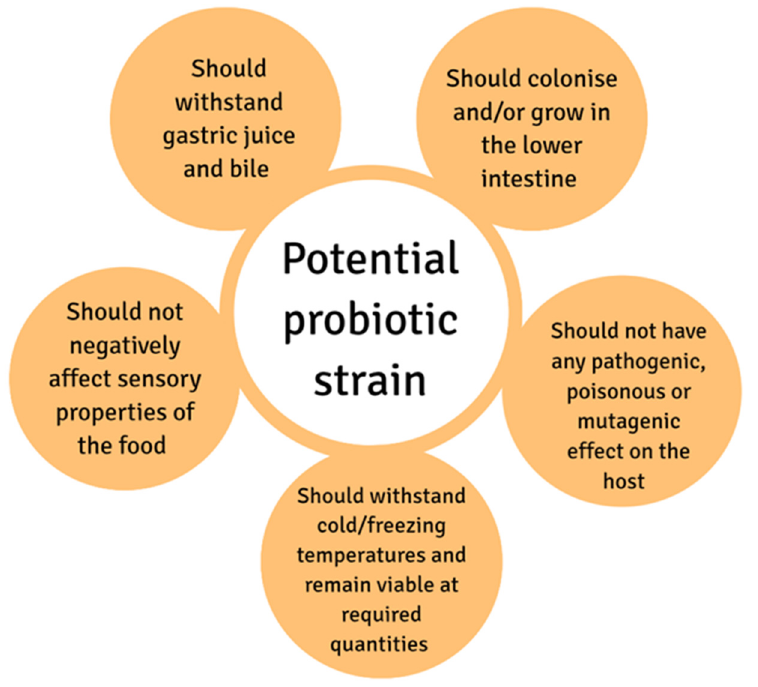
Figure 1. Technological and functional properties of a potential probiotic strain.